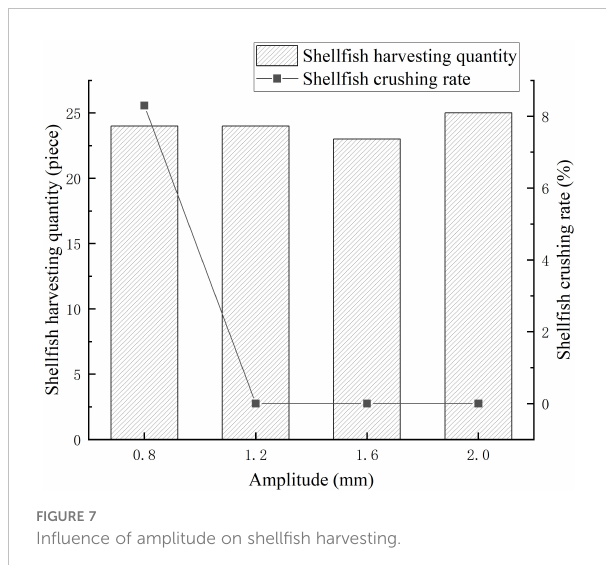
FIGURE 7 In fl uence of amplitude on shell fi sh harvesting.